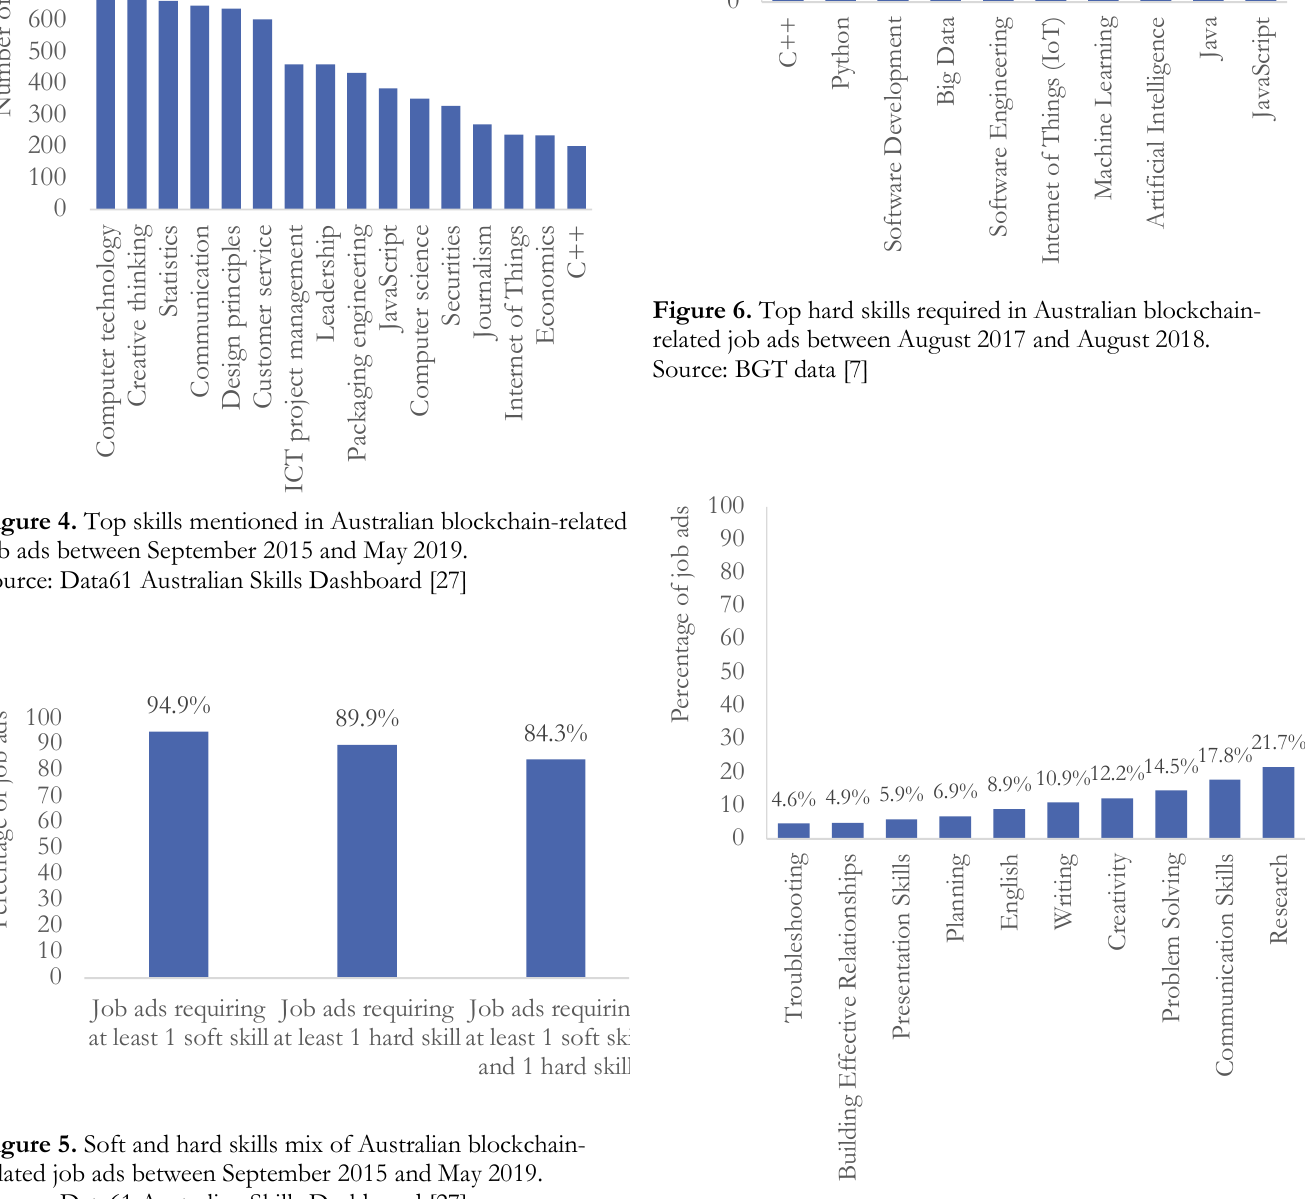
Figure 7. Top soft skills required in Australian blockchain- related job ads between August 2017 and August 2018. Source: BGT data